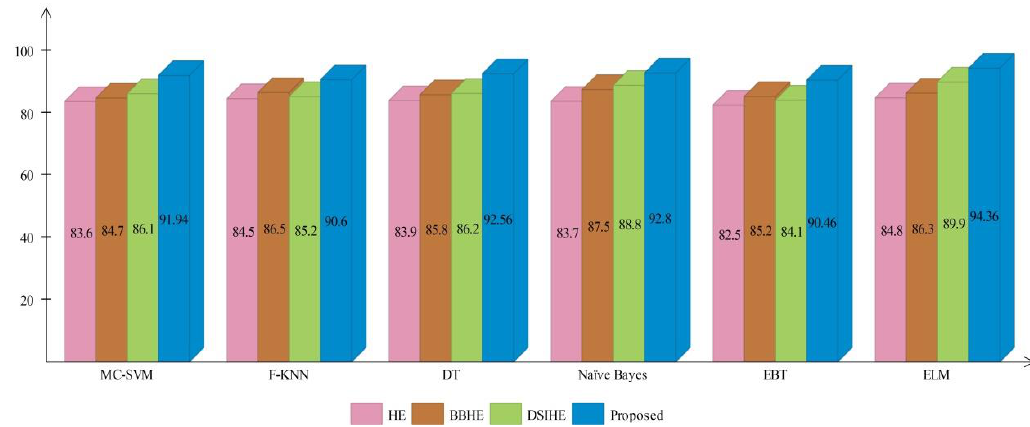
Figure 17. Comparison of different contrast enhancement techniques for ISIC2018 dataset .